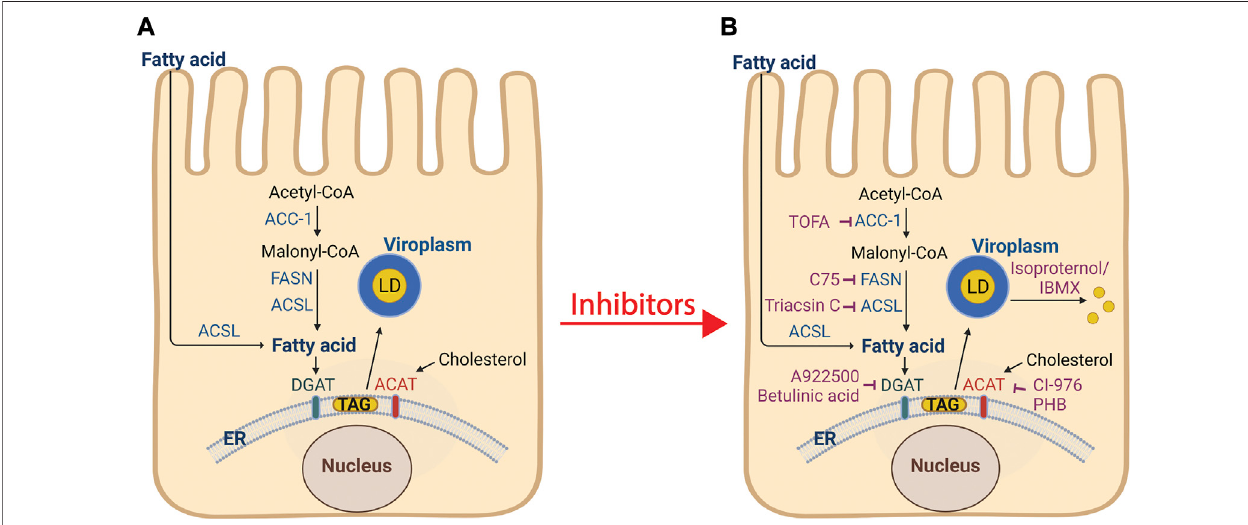
FIGURE 3 | Processes of lipogenesis and lipid droplet biogenesis, and interventions that disrupt viroplasm formation. (A) De novo fatty acid synthesis involves the conversion of acetyl-CoA into malonyl-CoA by acetyl-CoA carboxylase 1 (ACC-1). Fatty acid synthase (FASN) catalyzes the synthesis of the fatty acid palmitate from acetyl-CoA and malonyl-CoA. Long chain acyl-CoA synthetase (ACSL) facilitates extracellular fatty acid uptake and converts fatty acids into their corresponding CoA esters for oxidation or esteri fi cation into complex lipids (e.g., triglycerides, phospholipids, and cholesterol esters). The ER-localized enzymes diacylglycerol acyltransferases(DGAT1andDGAT2),andacyl-coenzymeA(CoA):cholesterolacyltransferases(ACAT1andACAT2)synthesizetriacylglycerol(Tauchi-Satoetal.,2002) from fatty acids and sterol esters from cholesterol, respectively. These products are stored in the lipid bilayer of the ER. The current model of lipid droplet biogenesis posits that the TAG and sterol esters accumulate and by an unknown mechanism bud from the ER into the cytoplasm and acquire lipid droplet-associated proteins (PLINs 1-5). RV viroplasms associate with lipid droplets. (B) Inhibitors (shown in purple) that block lipid droplet formation or disperse lipid droplets signi fi cantly decrease the number and size of viroplasms and the amount of infectious viral progeny. Treatment of cells with isoproterenol and IBMX fragment lipid droplets into smaller microdroplets. Image created with BioRender (BioRender.com). Modi fi ed from Crawford and Desselberger, 2016 (Crawford and Desselberger, 2016).